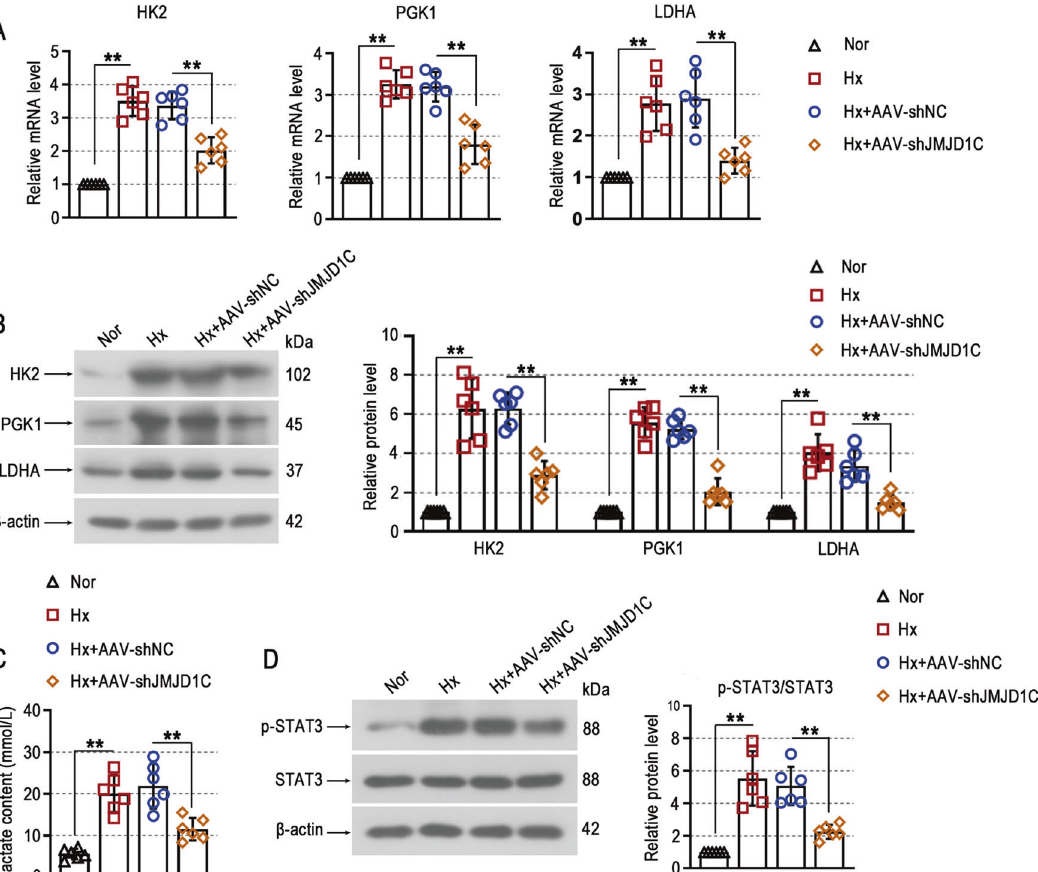
D The protein levels of p-STAT3 and STAT3 were examined using Western blotting. Nor Normoxia, Hx Hypoxia. The values are the mean ± SD, and statistical signi fi cance was determined by one-way ANOVA. N = 6, ** p <